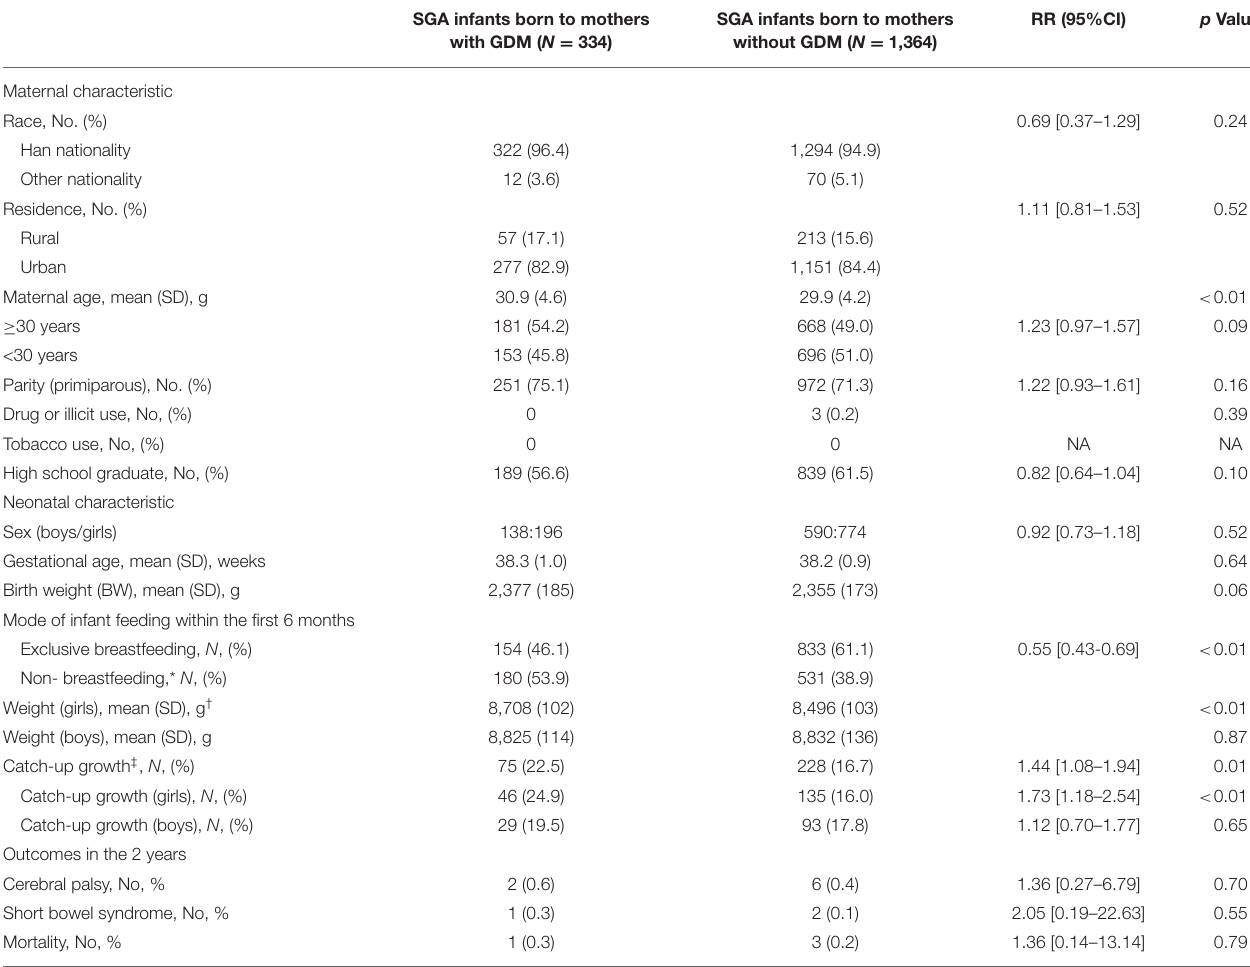
TABLE 3 | The follow-up outcomes of SGA infants born to mothers with and without GDM ( N = 1,698).